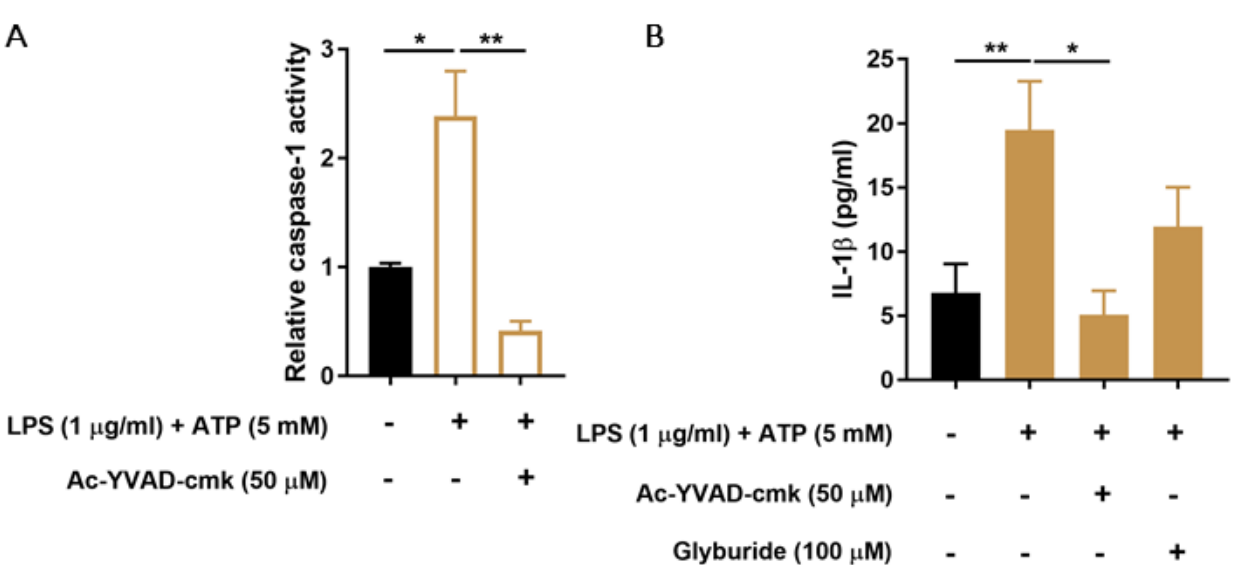
Figure 1. Effect of LPS and ATP on caspase-1 activity and IL-1 β production in ciPEC-OAT1. ( A ) Relative caspase-1 activity in ciPTEC-OAT1 upon exposure to LPS (1 μ g/mL; 2 h) and ATP (5 mM; 30 min) in the absence or presence of specific caspase-1 inhibitor, ac-YVAD-cmk (50 μ M). ( B ) IL-1 β secreted levels (pg/mL) by ciPEC-OAT1 following 24 h treatment with LPS (1 μ g/mL; 24 h) and ATP (5 mM; 30 min), in the absence or presence of inhibitors ac-YVAD-cmk (50 μ M) or glyburide (100 μ M). Data are derived from three independent experiments performed in duplicate and expressed